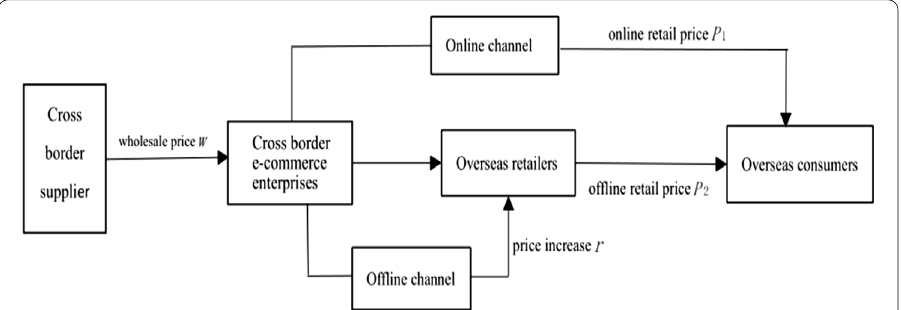
Fig. 1 Cross-border e-commerce dual-channel supply